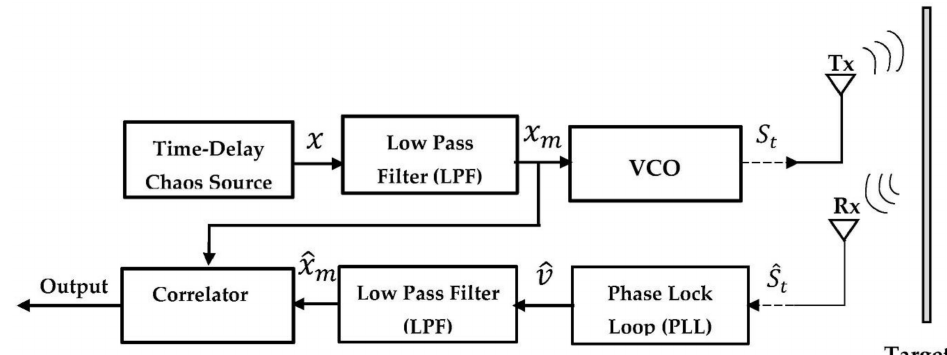
Figure 10. The block diagram of a Time-delayed Chaotic-FM Radar System.